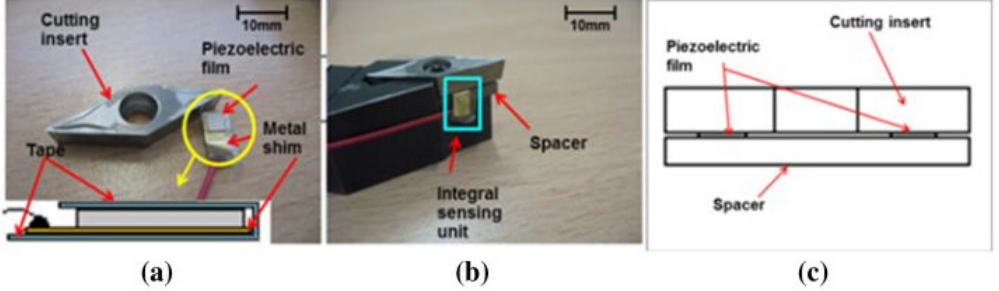
Figure 3. ( a ) Composition of the smart cutting tool, ( b ) assembly of the tool, ( c ) cross-section view of the tool, as taken from [10].